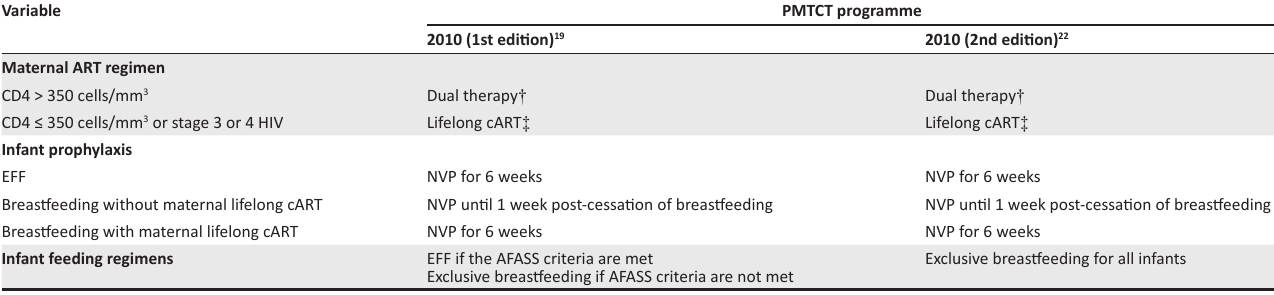
TABLE 2: Maternal antiretroviral therapy, infant prophylaxis and feeding regimens recommended by the South African national prevention of mother-to-child transmission programme of 2010 for human immunodeficiency virus-positive women during pregnancy and after delivery and their human immunodeficiency virus-exposed infants.